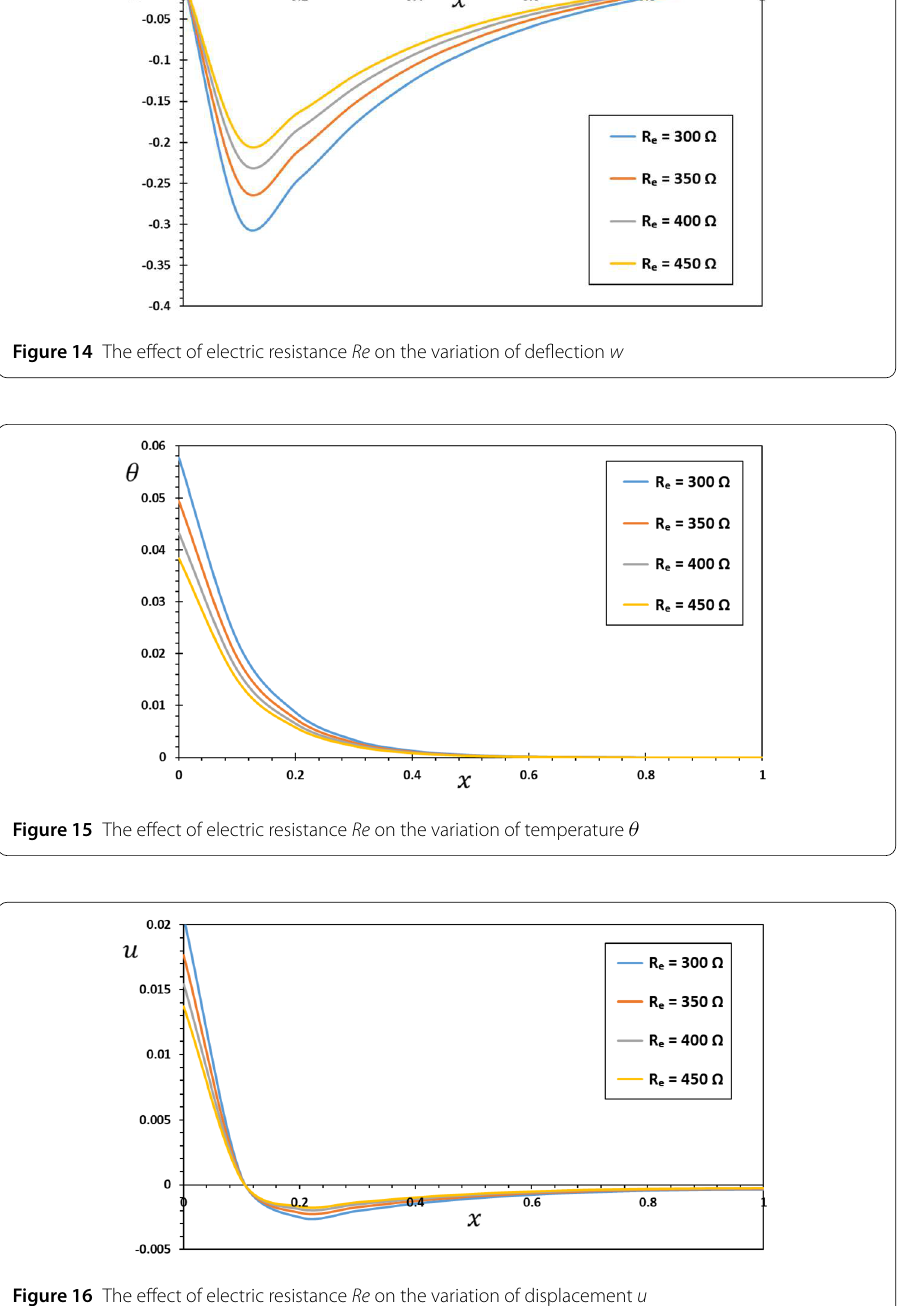
be noticed from graph 15 that the thermoelectric effect causes a rapid rise in temperature θ over a small distance near the first end of the beam, although the strength of the re- sulting curves varies with the electrical resistance Re . Three separate displacements u and bending moment M curves (Figs. 16 and 17) show how the peak values decrease with in- creasing electrical resistance values. It was found that the maximum values of these fields decreased with movement in the direction of the x -axis. Figure 17 presents the graphs